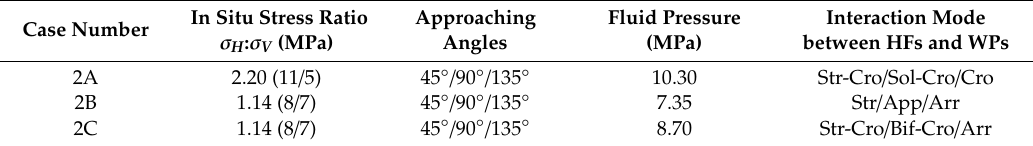
Table 5. Experimental scheme of Group